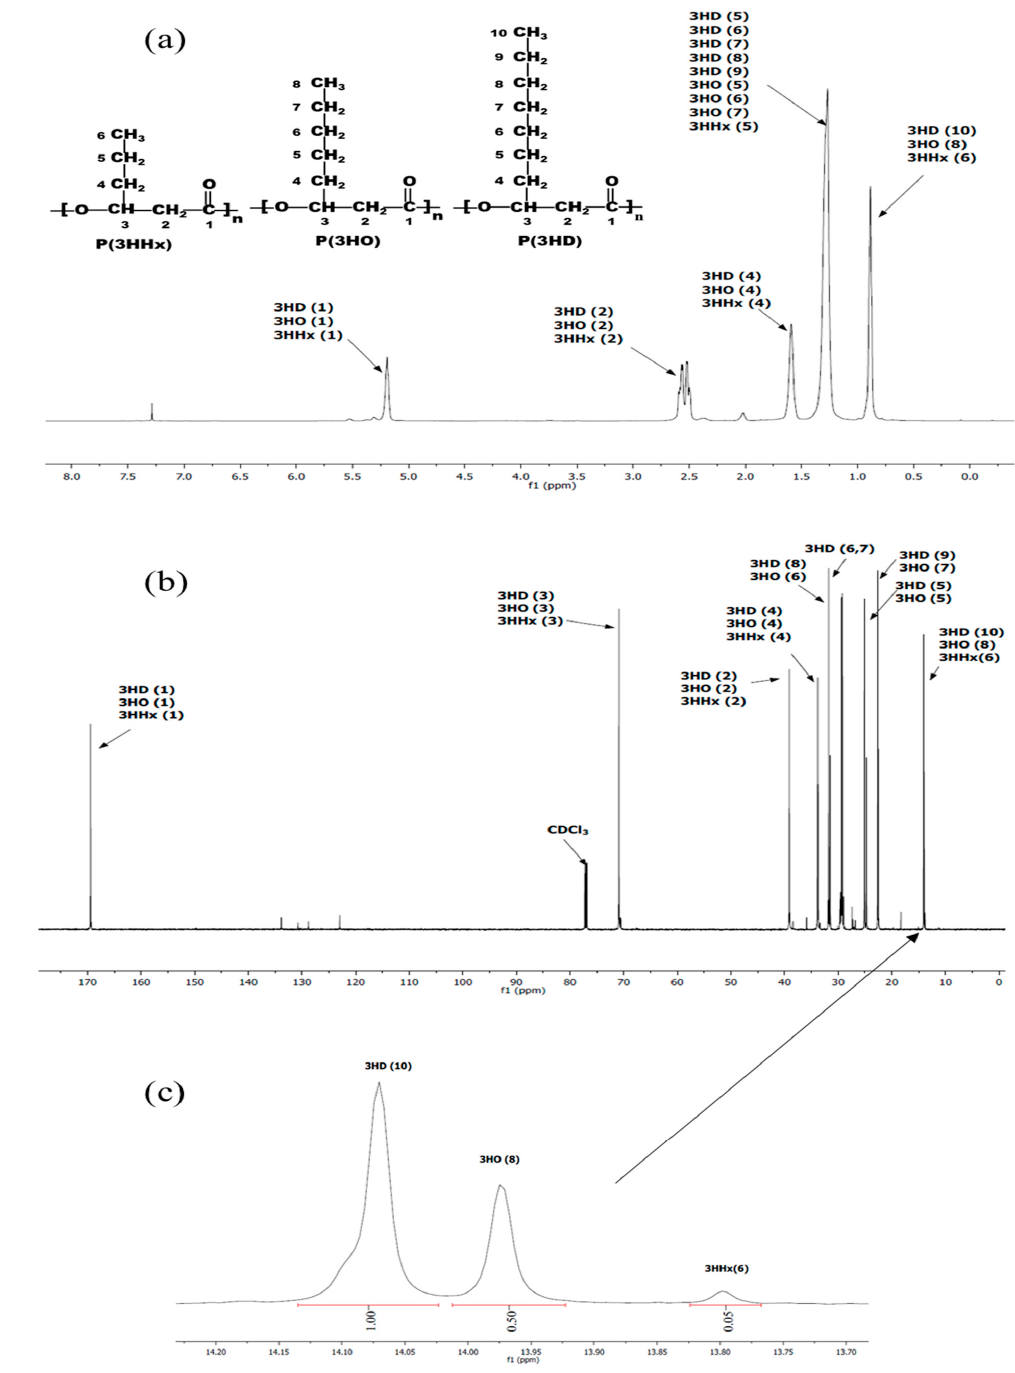
Figure 5. NMR spectra of the extracted MCL-PHA terpolyester sample: ( a ) 1 H NMR, ( b ) 13 C NMR and ( c ) enlarged 13 C NMR spectrum of P(3HHx- co -3HO- co -3HD) at the terminal carbon group (CH 3 ) of 3HD, 3HO, and 3HHx.